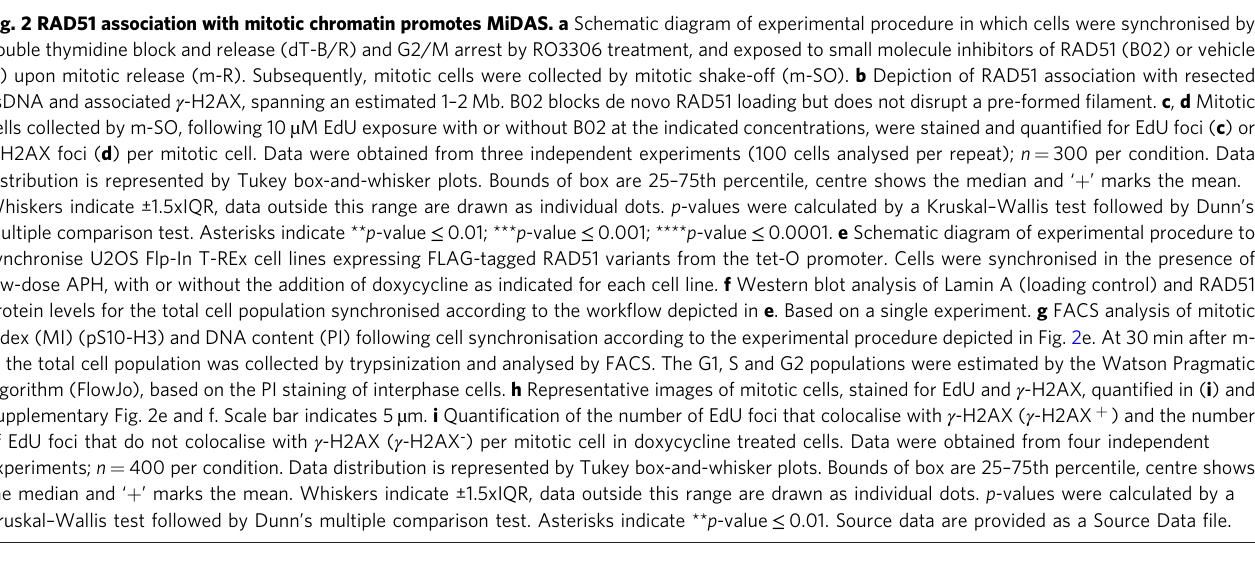
Fig. 2 RAD51 association with mitotic chromatin promotes MiDAS. a Schematic diagram of experimental procedure in which cells were synchronised by double thymidine block and release (dT-B/R) and G2/M arrest by RO3306 treatment, and exposed to small molecule inhibitors of RAD51 (B02) or vehicle (-) upon mitotic release (m-R). Subsequently, mitotic cells were collected by mitotic shake-off (m-SO). b Depiction of RAD51 association with resected ssDNA and associated γ -H2AX, spanning an estimated 1 – 2 Mb. B02 blocks de novo RAD51 loading but does not disrupt a pre-formed fi lament. c , d Mitotic cells collected by m-SO, following 10 µ M EdU exposure with or without B02 at the indicated concentrations, were stained and quanti fi ed for EdU foci ( c ) or γ -H2AX foci ( d ) per mitotic cell. Data were obtained from three independent experiments (100 cells analysed per repeat); n = 300 per condition. Data distribution is represented by Tukey box-and-whisker plots. Bounds of box are 25 – 75th percentile, centre shows the median and ‘ + ’ marks the mean. Whiskers indicate ±1.5xIQR, data outside this range are drawn as individual dots. p- values were calculated by a Kruskal – Wallis test followed by Dunn ’ s multiple comparison test. Asterisks indicate ** p -value ≤ 0.01; *** p -value ≤ 0.001; **** p -value ≤ 0.0001. e Schematic diagram of experimental procedure to synchronise U2OS Flp-In T-REx cell lines expressing FLAG-tagged RAD51 variants from the tet-O promoter. Cells were synchronised in the presence of low-dose APH, with or without the addition of doxycycline as indicated for each cell line. f Western blot analysis of Lamin A (loading control) and RAD51 protein levels for the total cell population synchronised according to the work fl ow depicted in e . Based on a single experiment. g FACS analysis of mitotic index (MI) (pS10-H3) and DNA content (PI) following cell synchronisation according to the experimental procedure depicted in Fig. 2e. At 30 min after m- R, the total cell population was collected by trypsinization and analysed by FACS. The G1, S and G2 populations were estimated by the Watson Pragmatic algorithm (FlowJo), based on the PI staining of interphase cells. h Representative images of mitotic cells, stained for EdU and γ -H2AX, quanti fi ed in ( i ) and Supplementary Fig. 2e and f. Scale bar indicates 5 µ m. i Quanti fi cation of the number of EdU foci that colocalise with γ -H2AX ( γ -H2AX + ) and the number of EdU foci that do not colocalise with γ -H2AX ( γ -H2AX - ) per mitotic cell in doxycycline treated cells. Data were obtained from four independent experiments; n = 400 per condition. Data distribution is represented by Tukey box-and-whisker plots. Bounds of box are 25 – 75th percentile, centre shows the median and ‘ + ’ marks the mean. Whiskers indicate ±1.5xIQR, data outside this range are drawn as individual dots. p- values were calculated by a Kruskal – Wallis test followed by Dunn ’ s multiple comparison test. Asterisks indicate ** p -value ≤ 0.01. Source data are provided as a Source Data